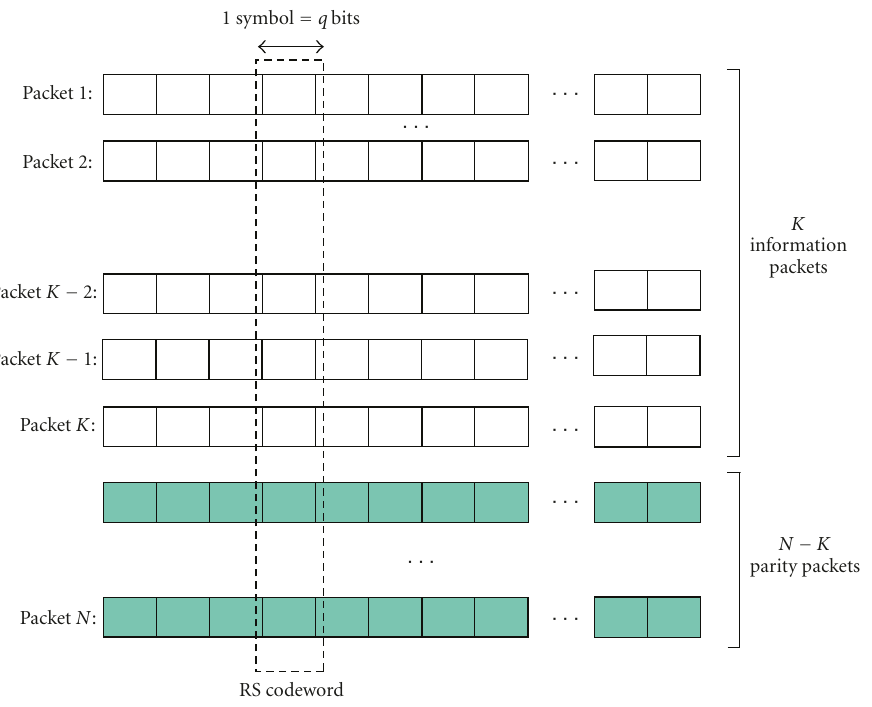
Figure 5: Construction of a packet